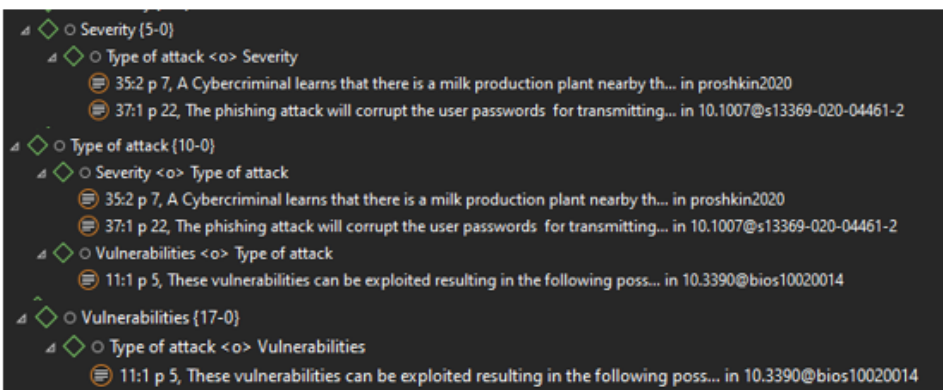
Figure 6. Concurrence-Table option of Atlas TI to identify the relationships between codes. Table 4. Analysis of the factors of IoT devices that are covered by the proposals of IoT risk method- ologies.